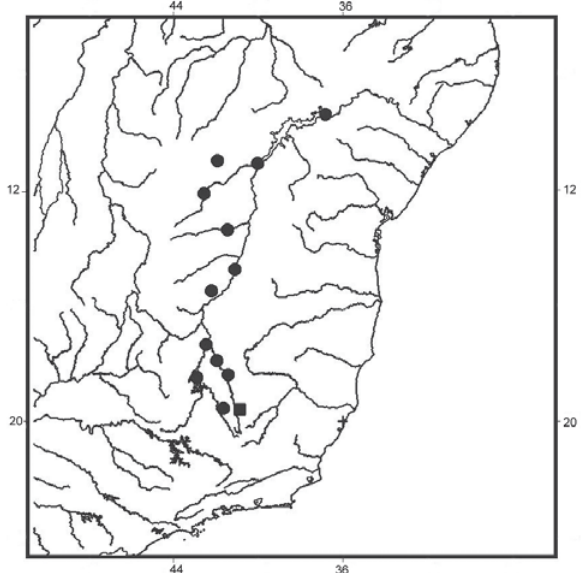
Fig. 3. Salminus franciscanus (not preserved), SL unrecorded, 44°16’W; coloration in life. Photo by Carlos B.M. Alves.